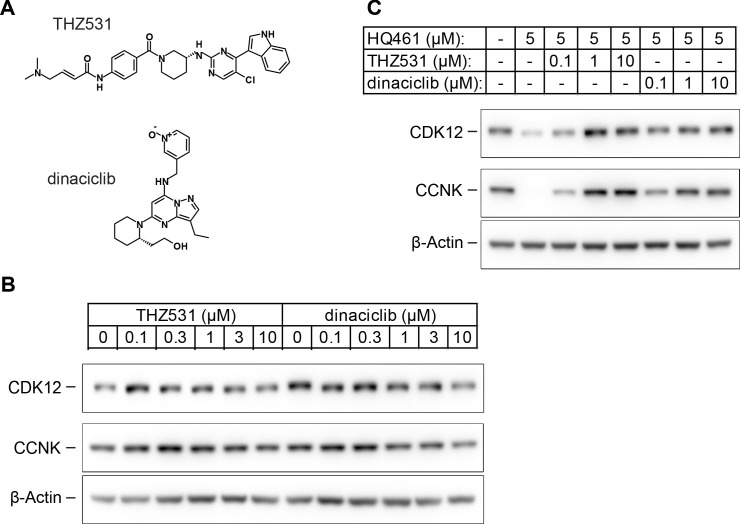
HQ461 binds to the ATP-binding pocket of CDK12.(A) Chemical structures of THZ531 and dinaciclib. (B) Effect of THZ531 and dinaciclib on CCNK and CDK12 protein levels in A549 cells. (C) Effect of THZ531 and dinaciclib on CCNK and CDK12 protein levels in A549 cells treated with HQ461.